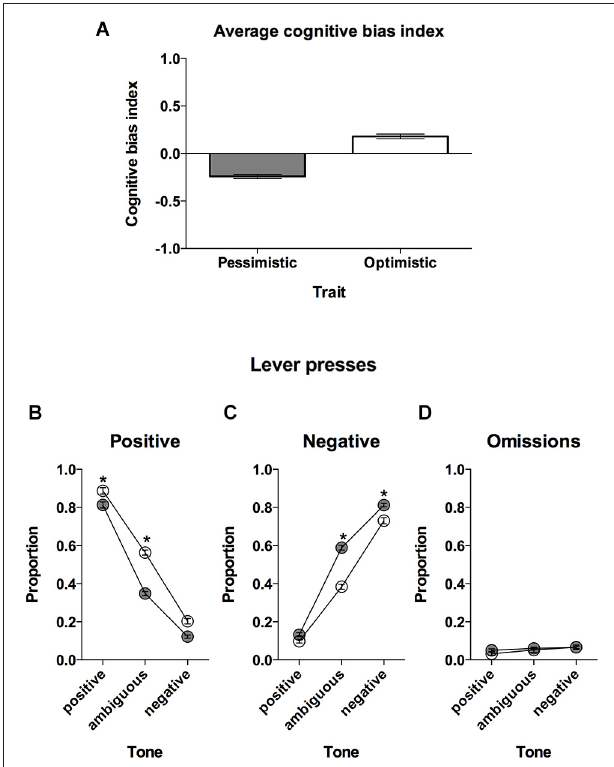
FIGURE 2 | “Optimistic” vs. “pessimistic” animals; results of the cognitive bias screening . (A) The mean ± SEM cognitive bias index of the animals classified (based on 10 ACI tests) as “optimistic” (open bar, N = 24) vs. “pessimistic” (filled bar, N = 56). A cognitive bias index above 0 indicates an overall positive judgment and “optimistic” interpretation of the ambiguous cue. (B) The mean ± SEM proportions of positive, (C) negative and (D) omitted responses to the trained and ambiguous tones in the “optimistic” (open circles, N = 24) and “pessimistic” (filled circles, N = 56) rat groups. * indicates significant ( p < 0.05) differences between the “optimistic” and “pessimistic”